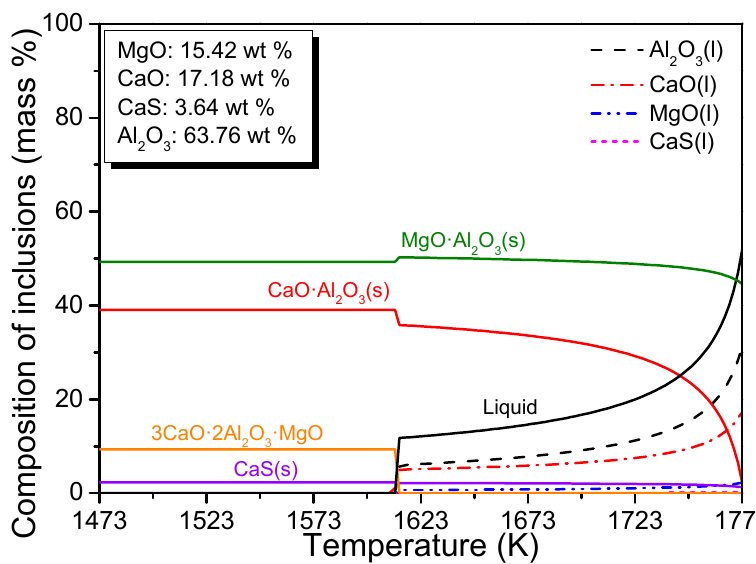
Figure 17. Precipitation of phases in inclusions with the decrease of temperature only considering inclusions.